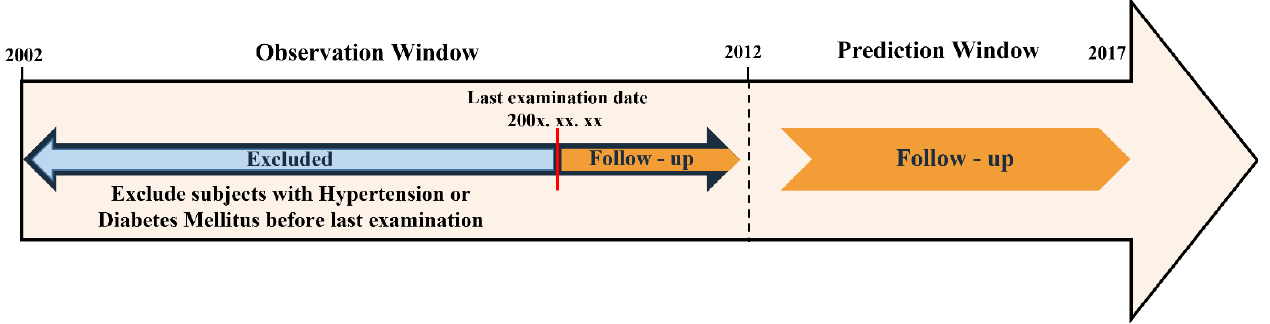
Figure 1. Study design.